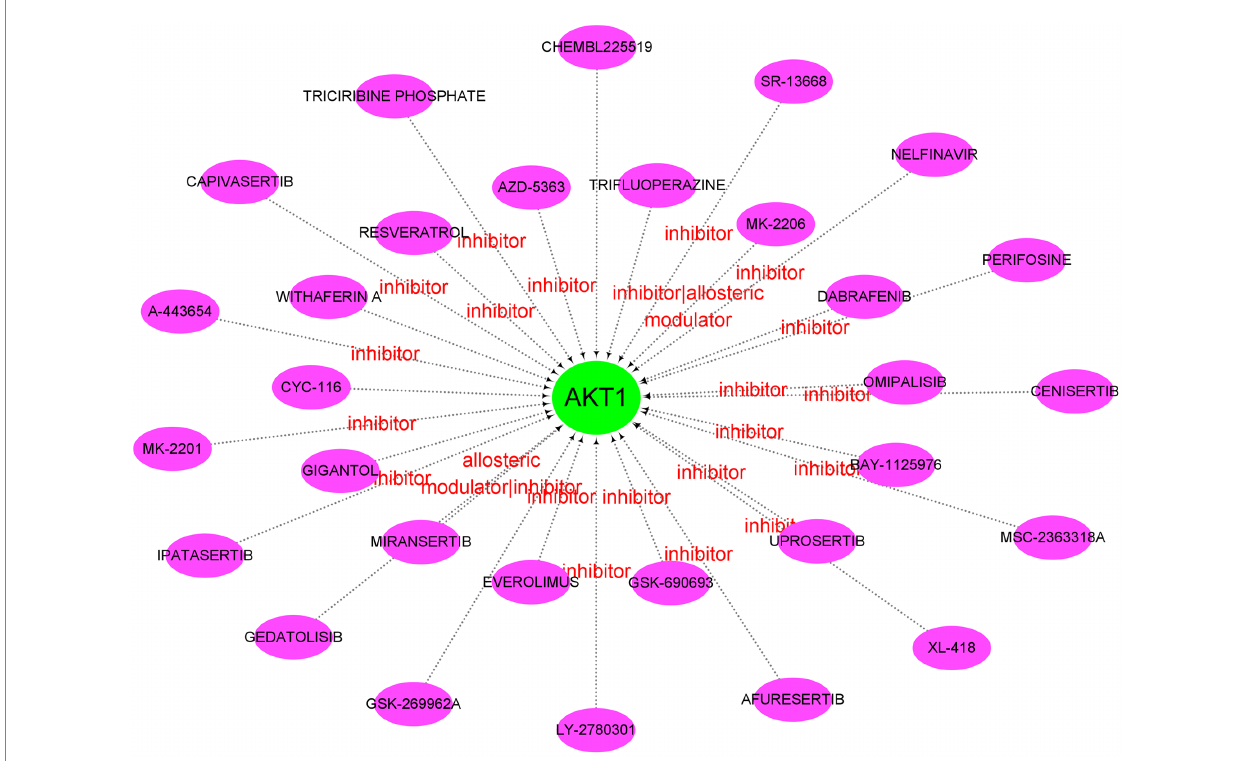
FIGURE 11 Drug-gene interaction network. Green circle nodes are pivotal genes and purple oval nodes are predicted drugs or molecular compounds. The red words represent the main drug-gene